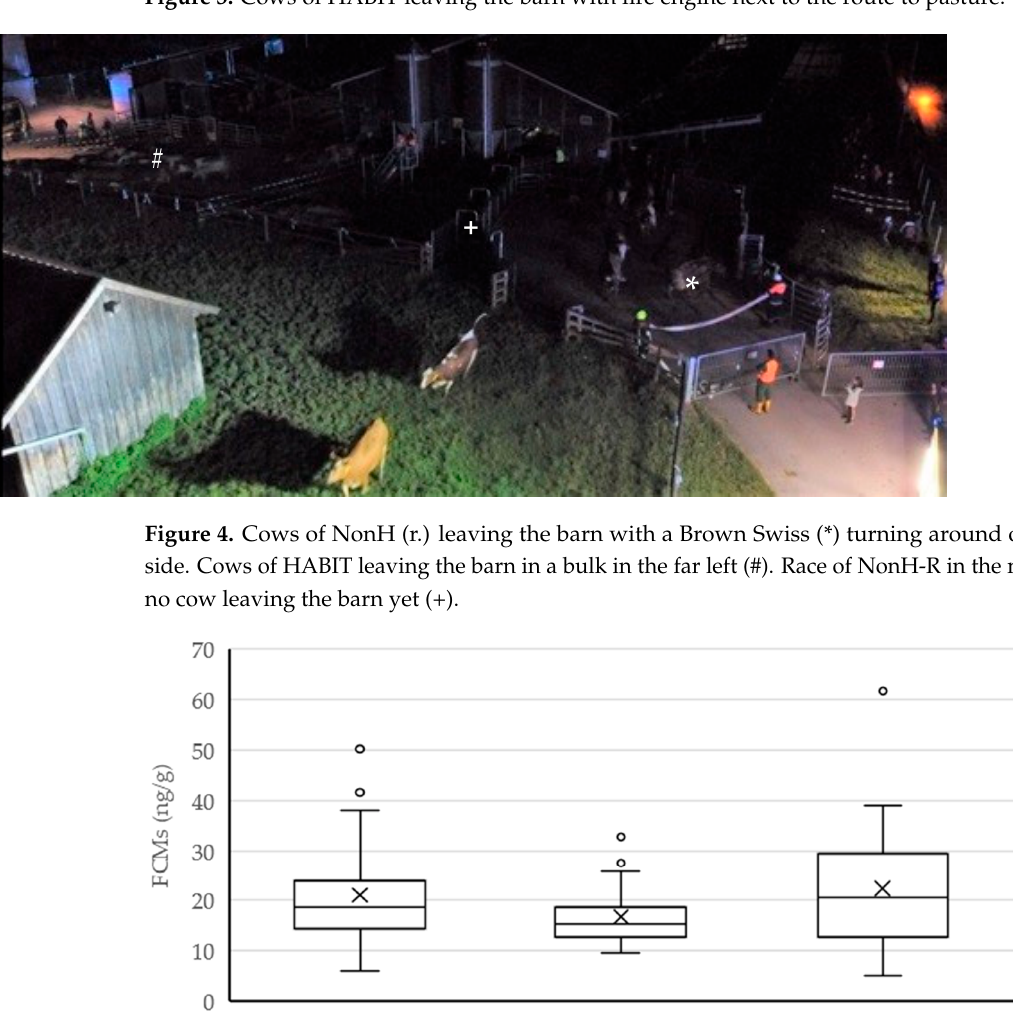
Figure 3. Cows of HABIT leaving the barn with fire engine next to the route to pasture.